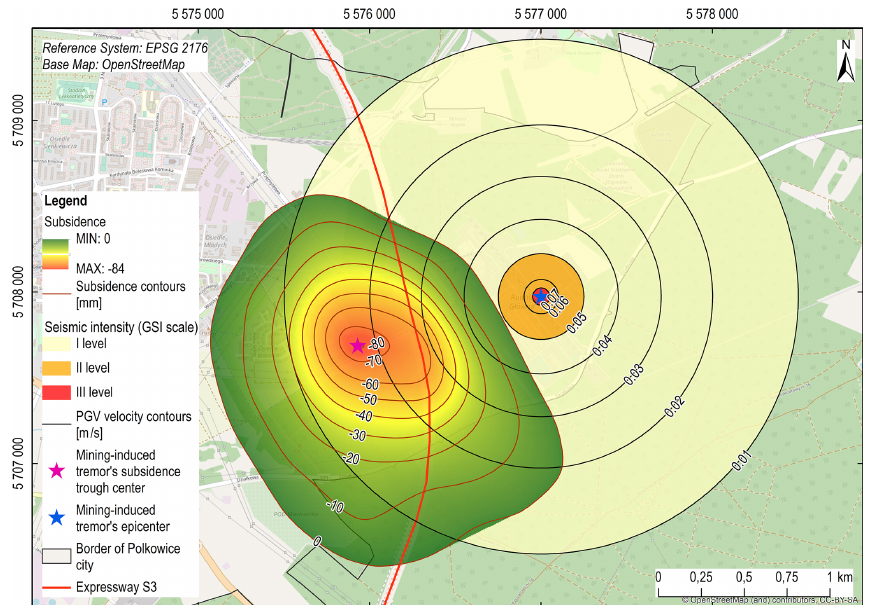
Figure 3. Map of land subsidence and seismic intensity zones resulted from mining-induced tremor occurring at 7 December 2017 (© Open- StreetMap contributors 2020. Distributed under a Creative Commons BY-SA